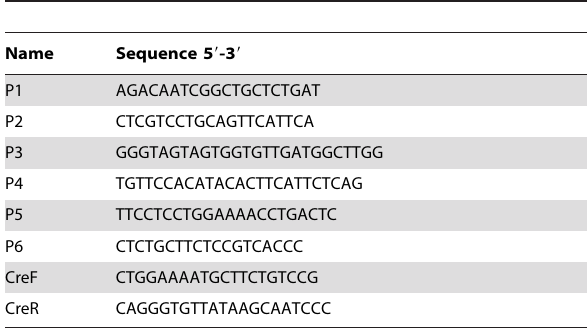
Table 1. PCR primers for genotyping of ES cells and mice